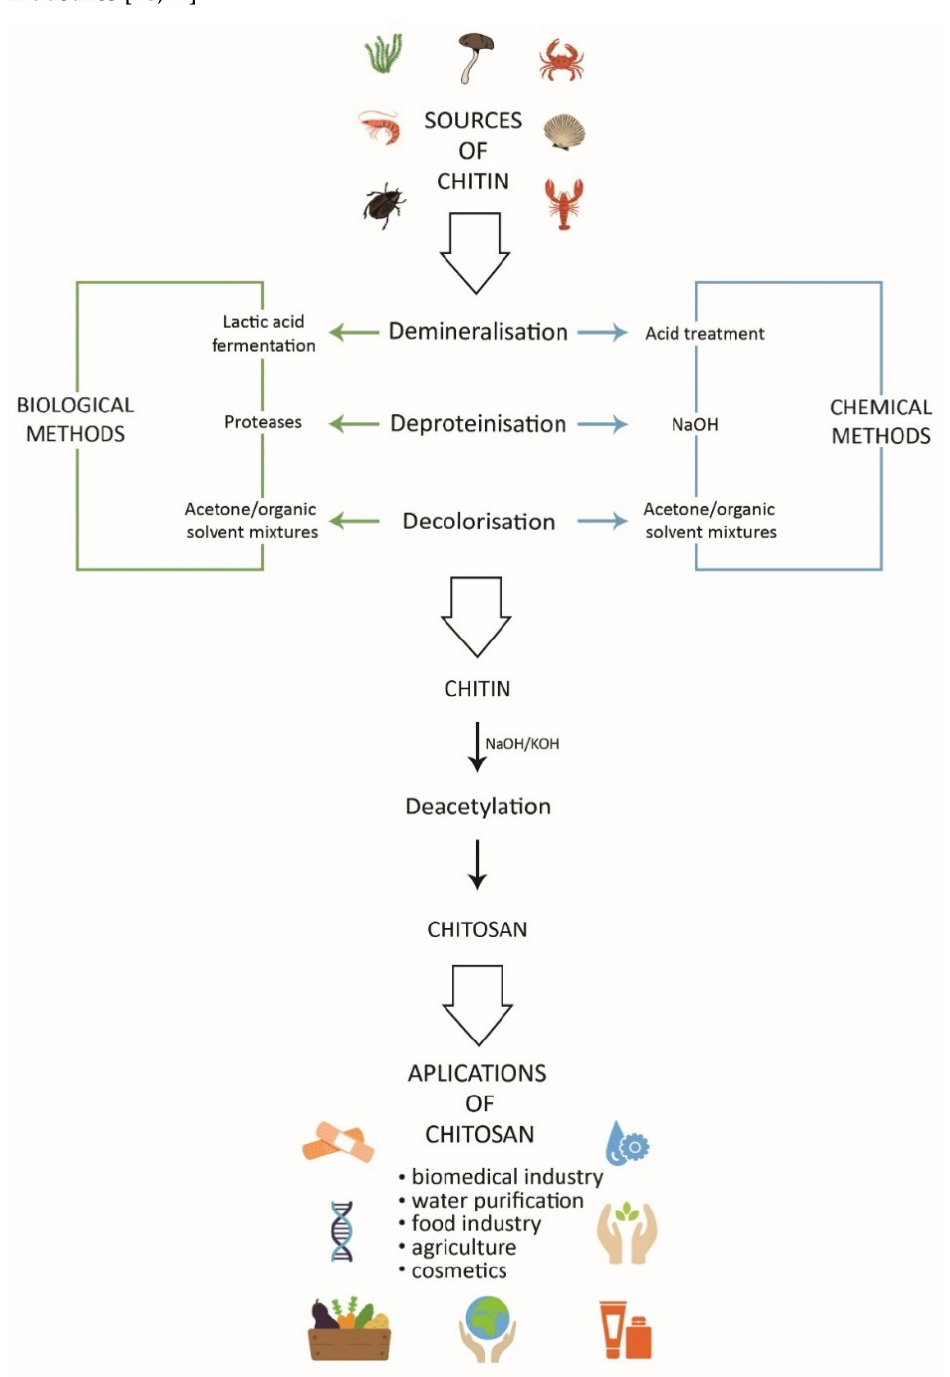
Figure 1. Extraction, preparation, and applications of chitosan and chitosan derivatives.